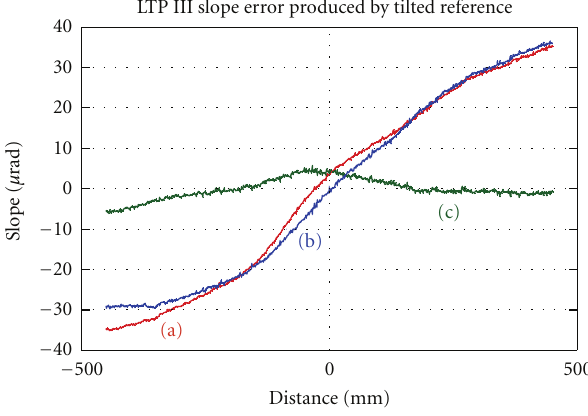
Figure 3: LTP III slope error produced by tilted reference. (a) Reference beam’s spot is tilted in 1.5mrad. (b) Nontilted reference beam at the center of the CCD. (c) Slope error caused by tilted reference.